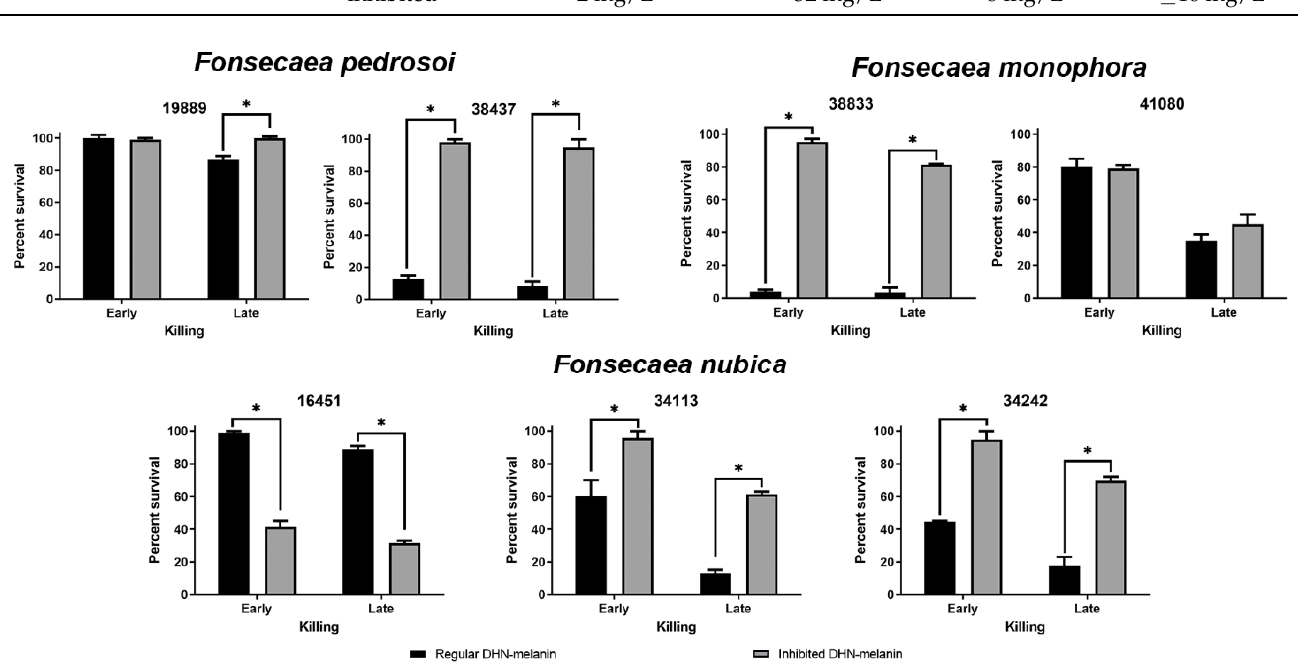
Figure 2. Survival rates of seven Fonsecaea spp. isolates against micafungin. Black bars indicate the survival of strains with regular DHN-melanin production. Gray bars indicate the survival of strains with DHN-melanin production inhibited by tricyclazole. The * indicates a significant difference ( p < 0.05) between regular and inhibited DHN-melanin production.